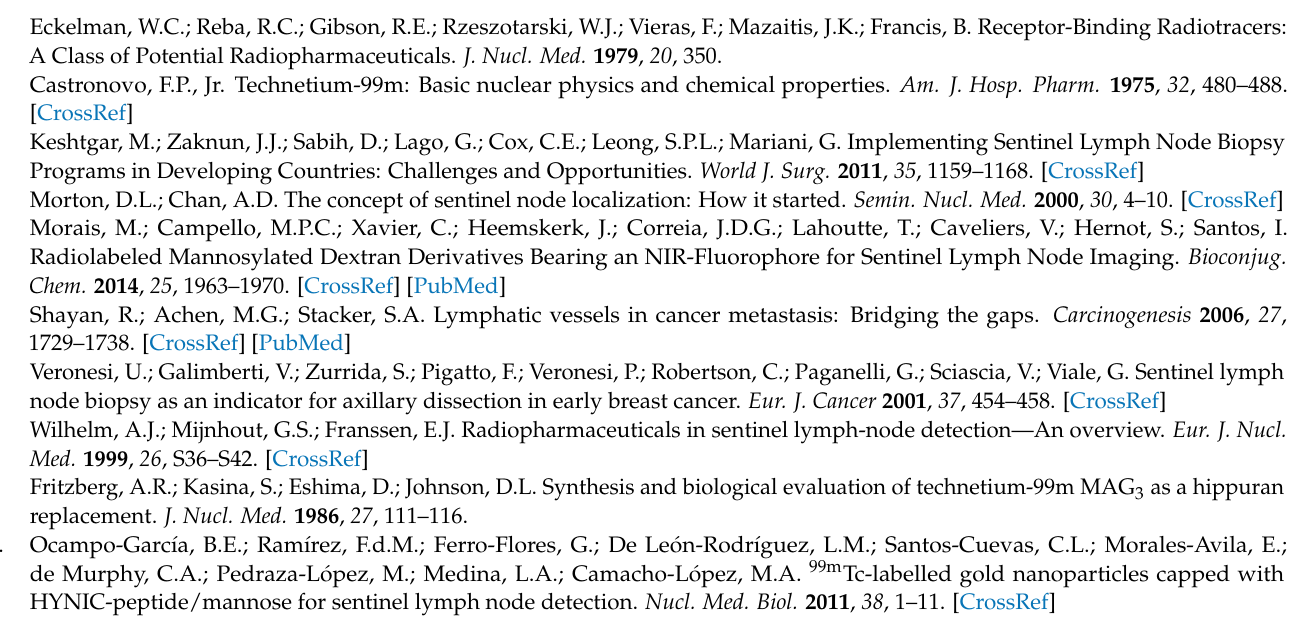
Supplementary Materials: The following are available online, Figure S1: 1 H NMR spectra (range δ